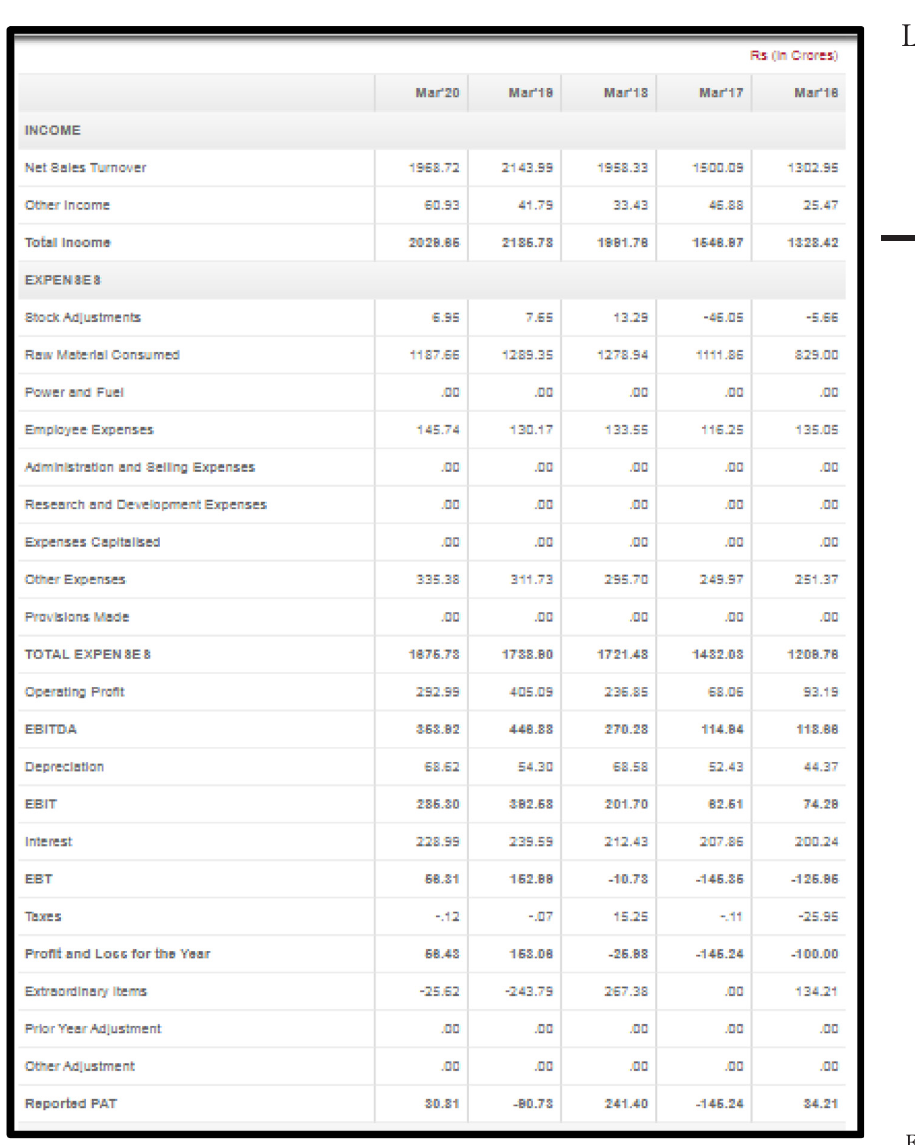
Figure 3. Financial results